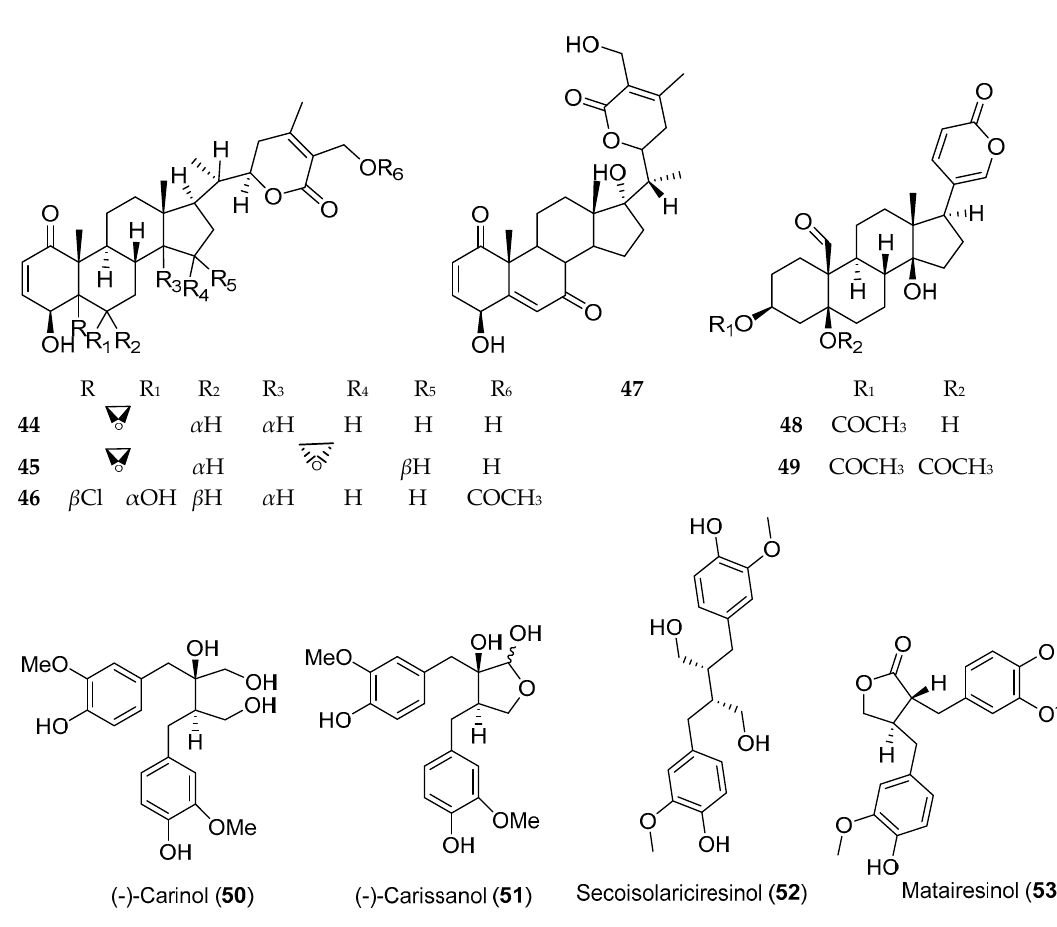
Figure 5. Structures of anticancer steroids and lignans reported from plants available in Ethiopia.